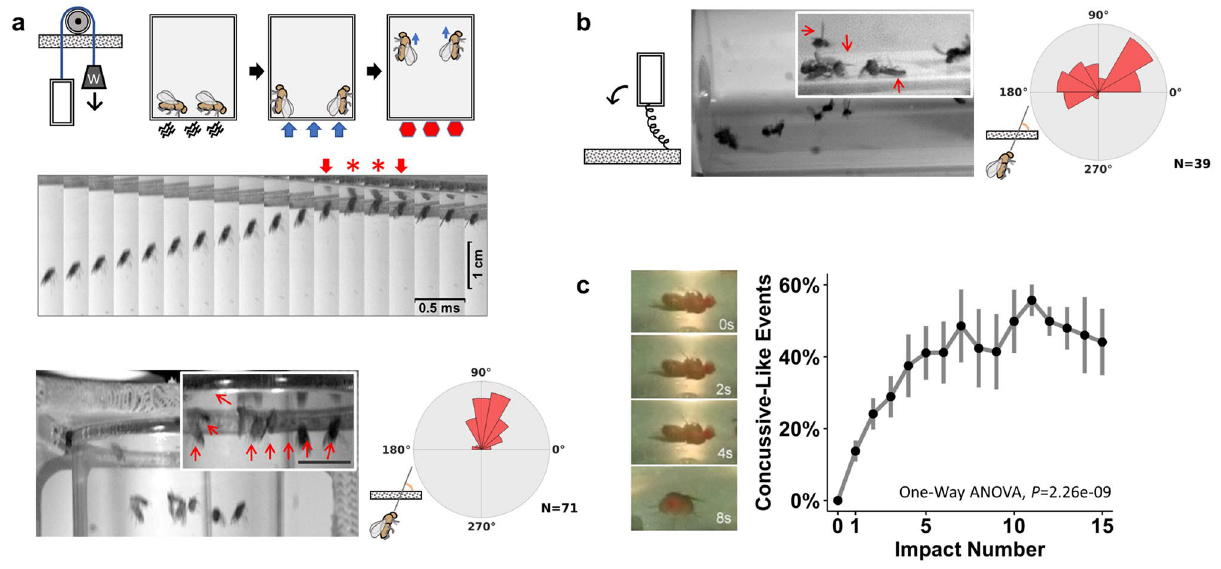
Figure 1. Development of a novel repetitive head impact Drosophila model. ( a) (Top) Diagram of our novel headfirst impact model that utilizes a counterweight pulley system to accelerate a vial of flies upward ultimately resulting in acceleration-deceleration headfirst impacts. To prime proper body orientation, the vial is lightly tamped down, resulting in the natural negative geotactic upwards orientation, after which the vial is release, causing the counterweight to accelerate the vial unidirectionally. The unidirectional movement upwards, together with the priming sequences facilitates headfirst orientation at impact once the vial reaches its maximum height. (Middle) High-speed image sequence showing headfirst movement through impact with the surface of the injury vial (arrows indicate frames immediately before and after contact, which is denoted by red stars, which lasts ~ 1 ms long). (Bottom) Angular histogram comparisons demonstrate more reliable and consistent headfirst impacts and improves upon ( b) previously existing strategies which encourage rotational body movement that results in inconsistent head orientation at impact. ( c) Immediately following headfirst impacts, flies sustain acute signs of neurological injury, such as temporary loss of consciousness that becomes more prevalent with increasing number of repetitive head impacts. Impact number increases concussive-like events (one-way ANOVA, F (1,89) = 44.26645, P = 2.26e−09 ) . Data represented as mean ± SD, n = 4–8 vials (10 flies per vial) of both male and female